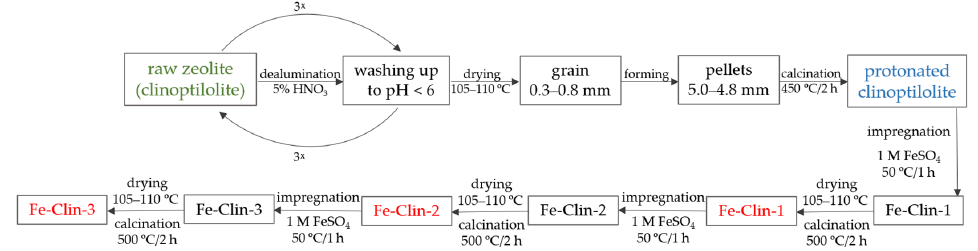
Figure 10. Schematic preparation procedure of Fe-clinoptilolite catalysts. The formed samples of protonated clinoptilolite and Fe-clinoptilolite catalysts, pre- pared on a laboratory scale, are presented in Figure 11A,B, respectively. The codes of the samples with the corresponding descriptions are listed in Table 4.